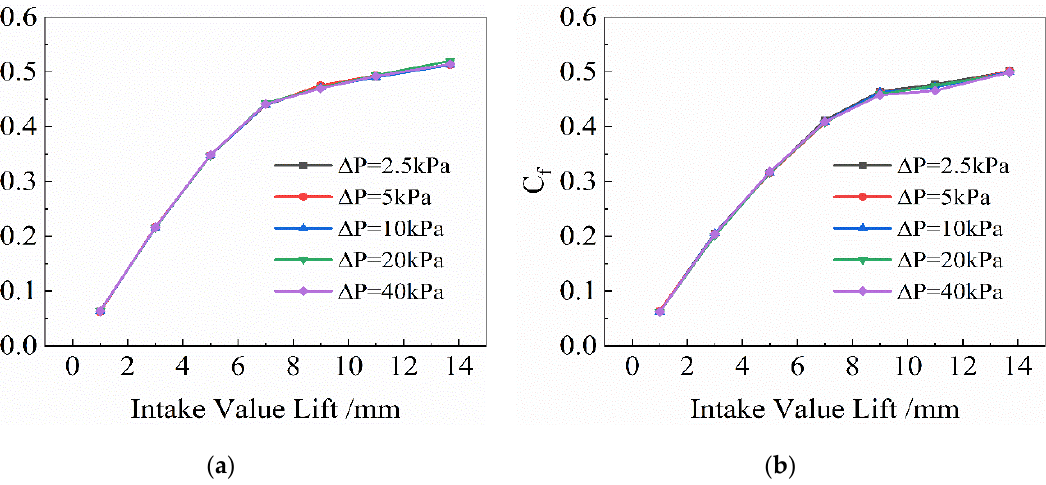
Figure 3. ( a ) Different intake pressure differences under 42 mm throat; ( b ) different intake pressure differences under 43 mm throat.